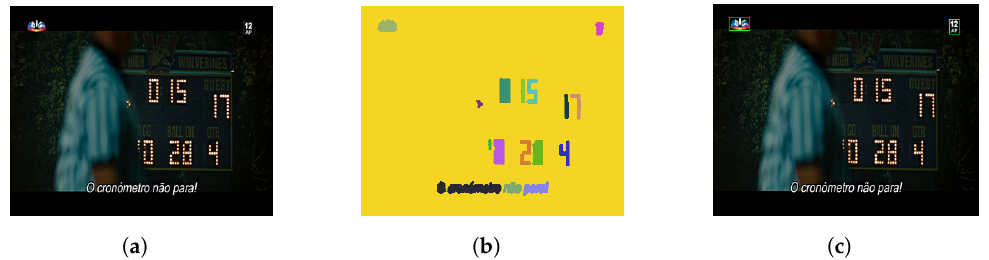
Figure 7. Frame 939 from the sic_cut3 stream, with corresponding graph-based segmentation. ( a ) Input Frame. ( b ) Graph-based Segmentation. ( c ) Selection of logo candidates from the graph segmentation after spatio-temporal stability